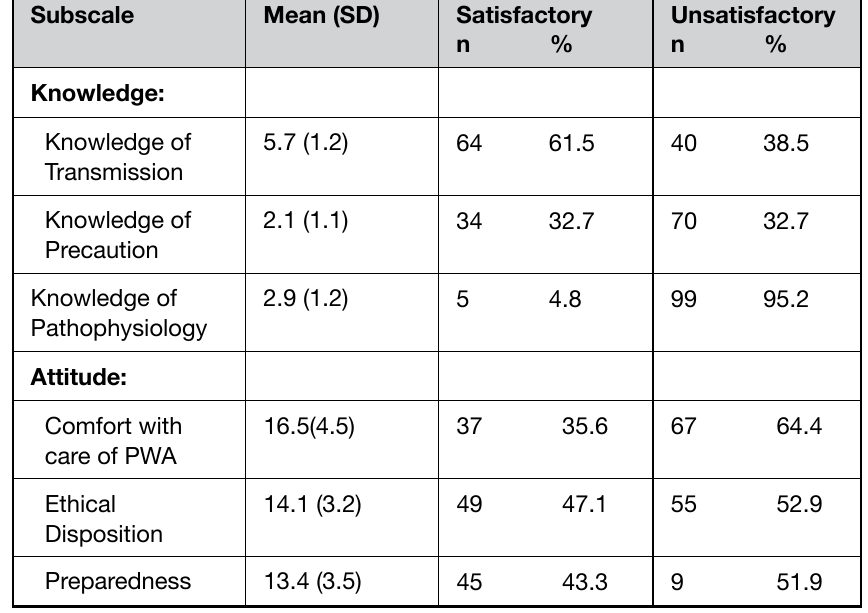
Table 2: Students’ scores on knowledge and affective traits